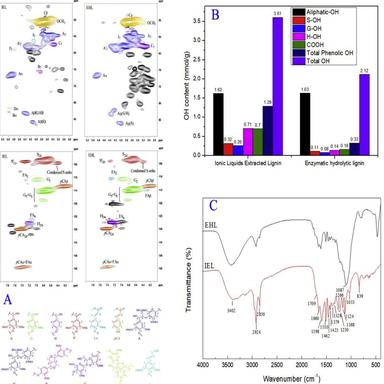
A: Side chain and aromatic regions in the 2D HSQC NMR spectra for the lignins (EHL and IEL). Color coding is according to the structures shown; B: Hydroxyl group distribution and contents analysis by 31P NMR; C: Comparative FT-IR analysis of lignins (EHL and IEL).